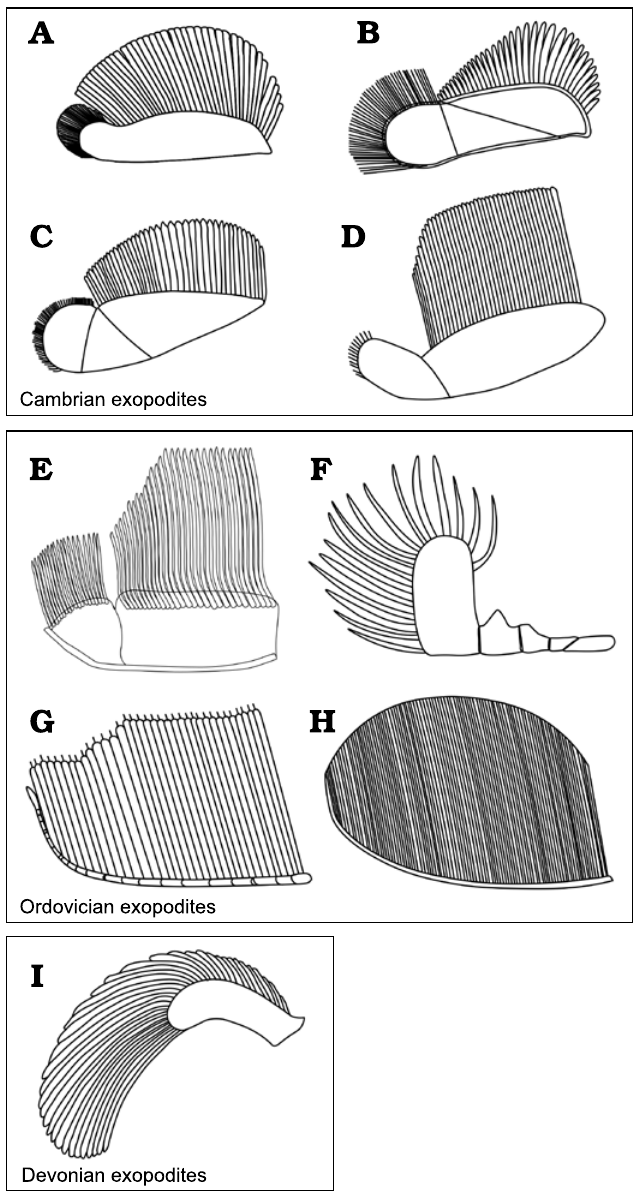
Fig. 10. Trilobite exopodite reconstructions grouped by geological